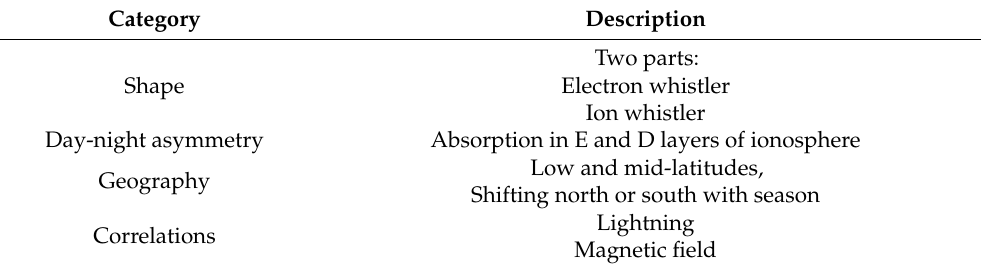
Table 2. Characteristics of whistlers.